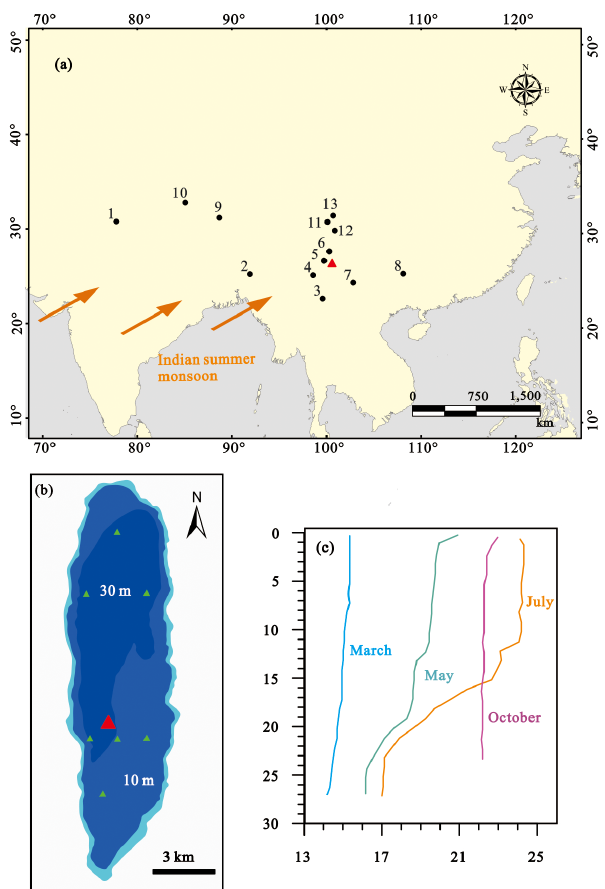
Figure 1. (a) Map showing the location of Lake Chenghai in south- west China (red triangle) and other sites (circles) mentioned in the text: (1) Bittoo Cave (Kathayat et al., 2016); (2) Mawmluh Cave (Dutt et al., 2015); (3) Lake Ximenglongtan (Ning et al., 2019); (4) Lake Tengchongqinghai (Zhang et al., 2017b; Li et al., 2018; Tian et al., 2019); (5) Lake Tiancai (Zhang et al., 2017a, 2019); (6) Lake Lugu (Wang et al., 2014); (7) Lake Xingyun (Wu et al., 2015, 2018); (8) Dongge Cave (Dykoski et al., 2005); (9) Nam Co (Günther et al., 2015); (10) Dangxiong Co (Ling et al., 2017); (11) Lake Yidun (Shen et al., 2006); (12) Lake Wuxu (Zhang et al., 2016); (13) Lake Muge (Ni et al., 2019). (b) The red triangle indi- cates the location of core CH2016 in Lake Chenghai, while green triangles indicate the locations of surface samples. (c) The vertical variation in Lake Chenghai water temperature in March, May, July and October (Lu,